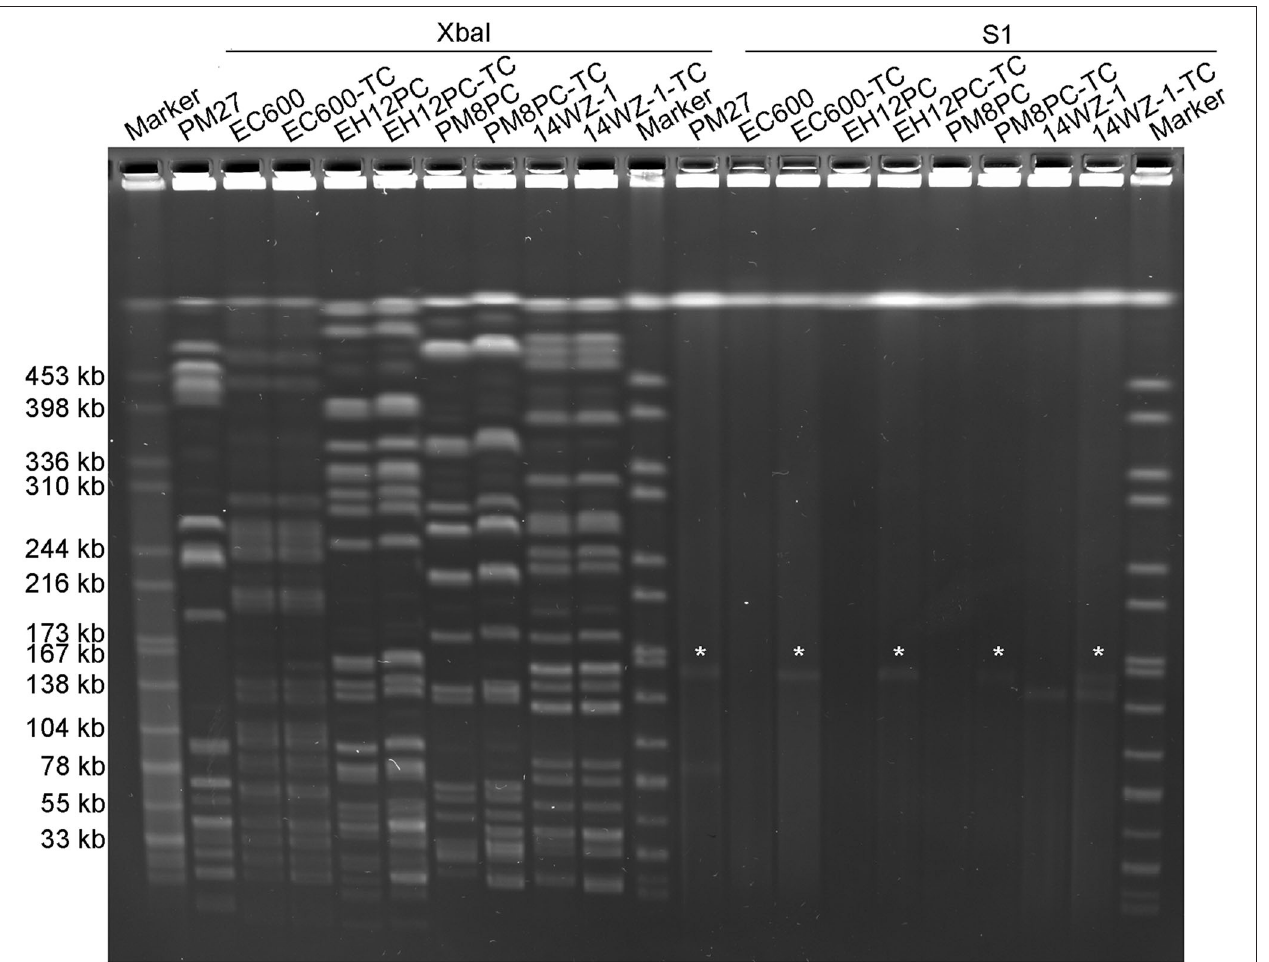
FIGURE 3 | XbaI PFGE and S1-PFGE analyses of the K. pneumoniae strain PM27 and its transconjugants. XbaI PFGE and S1-PFGE were repeated two times for all strains with the same results. “*” is denoted for virulence plasmid